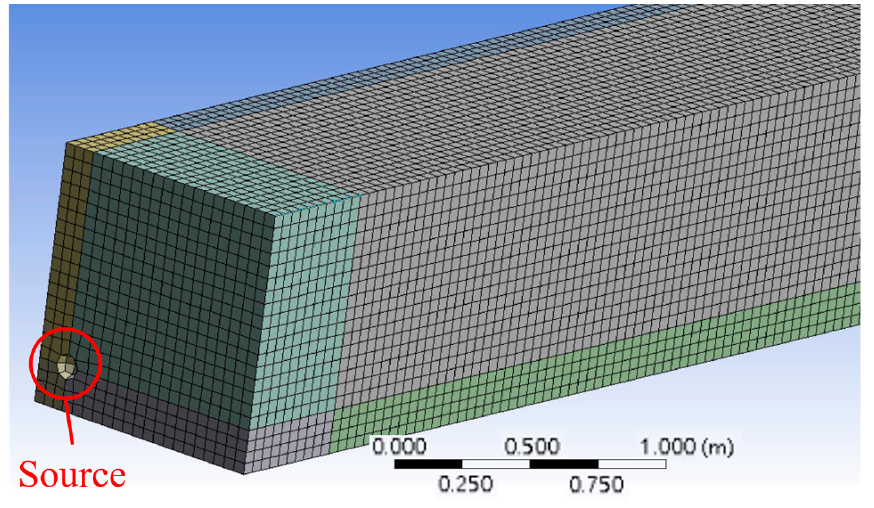
Figure 6. Grids of the constructed rectangular cuboid model.